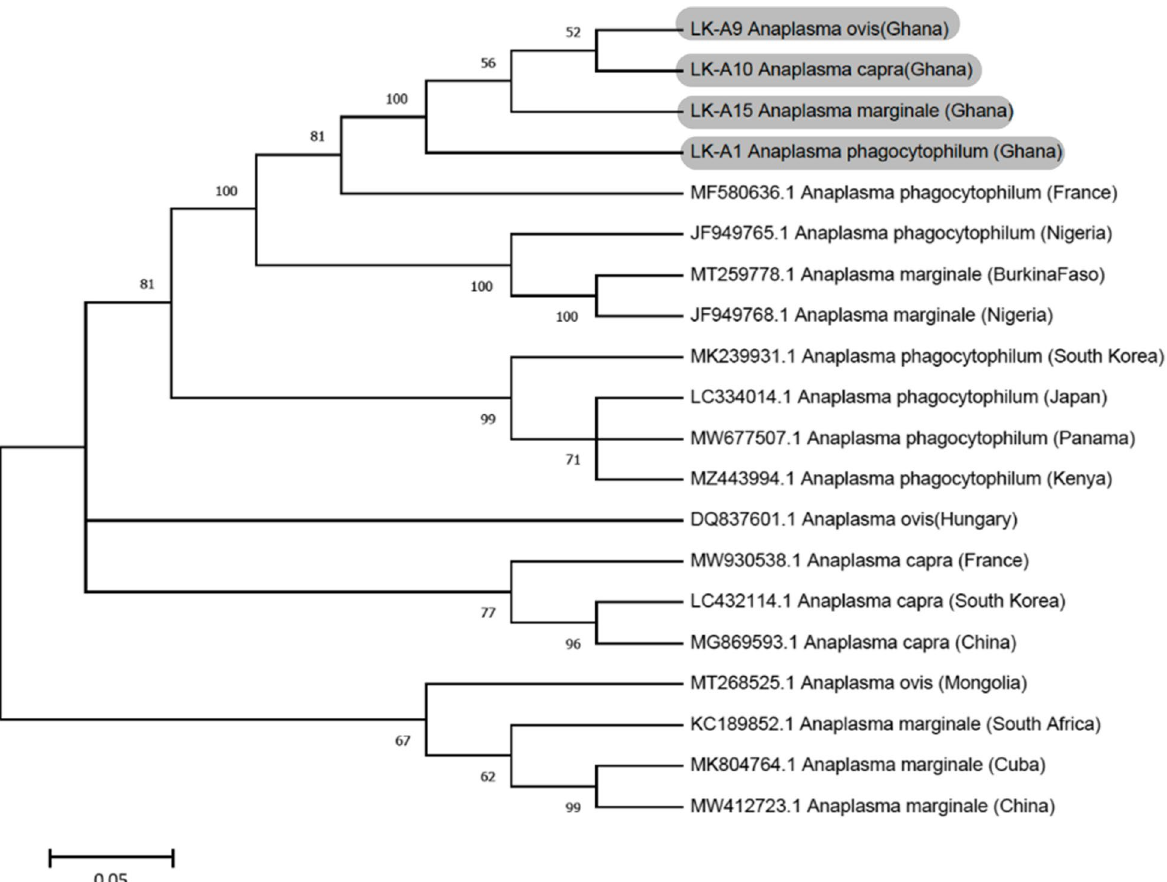
Fig. 2 Phylogenetic analysis of Anaplasma in the livestock based on the 16S rRNA gene. The sequences obtained in this study are indicated as LK‑A1, LK‑A9, LK‑A10 and LK‑A15